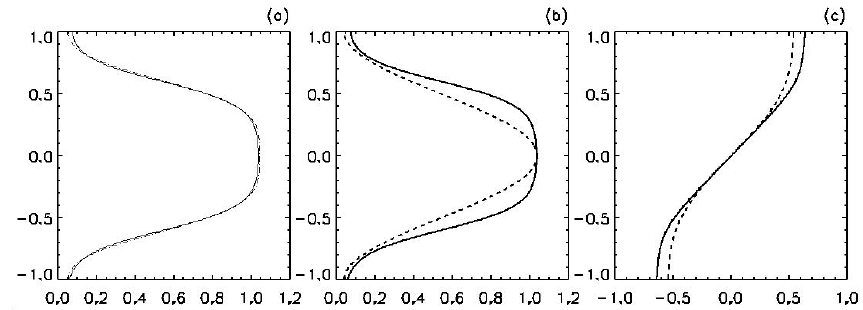
Fig. 1. Thermal ducting profiles used in Sect. 3.1.1. (a) Dashed line is a plot of the hyper-Gaussian function employed by Seylor (2005); solid line is for our profile composed of hyperbolic tangent derivatives, hereafter referred to as our composite profile. (b) The solid line is our composite profile and the dashed line is the cosine ducting stability profile. (c) The temperature profiles that yield the stability profiles in (b).